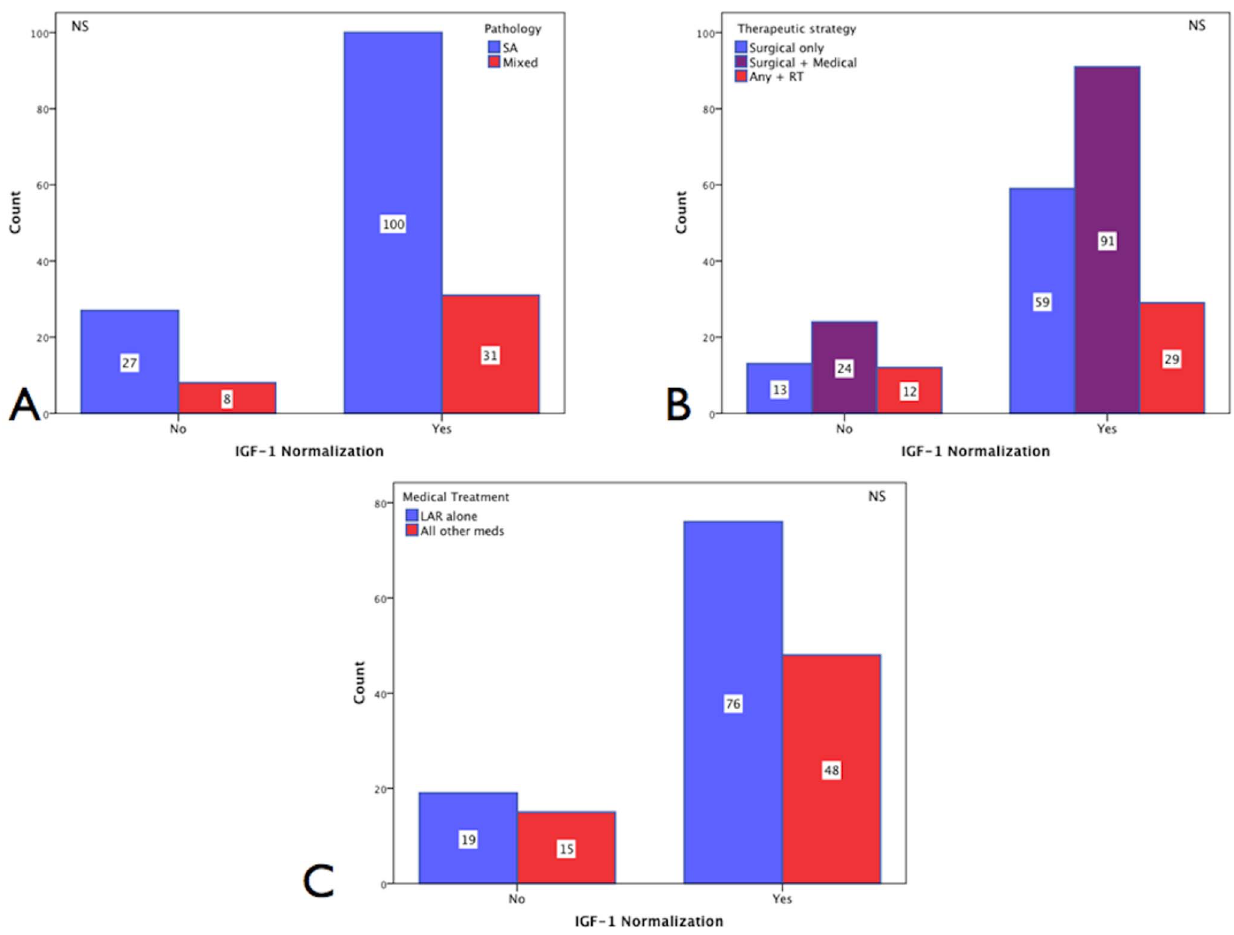
Figure 1. IGF-1 normalization. A. Pathology. IGF-1 normalization was achieved in 100 [60.2%] of those with pure SA and 31 [18.7%] cases of those with mixed tumors vs. 27 [16.3%] and 8 [4.8%] not normalizing [N=166] (NS). B. Therapeutic strategy. IGF-1 normalization was achieved by surgery in 59 [25.9%] cases, 91 [39.9%] by surgery + medical therapy, 29 [12.7%] by the addition of radiotherapy vs. 13 [5.5%], 24 [10.1%] and 12 [4.46%] cases in each group not normalizing IGF-1 [N=228] (NS). C. Medical treatment. IGF-1 normalization in the medically treated group was achieved in 76 [48.1%] cases using LAR alone, and 48 [30.4%] with other medications vs. 19 [12.0%] and 15 [9.5%] not achieving normalization [N=158]